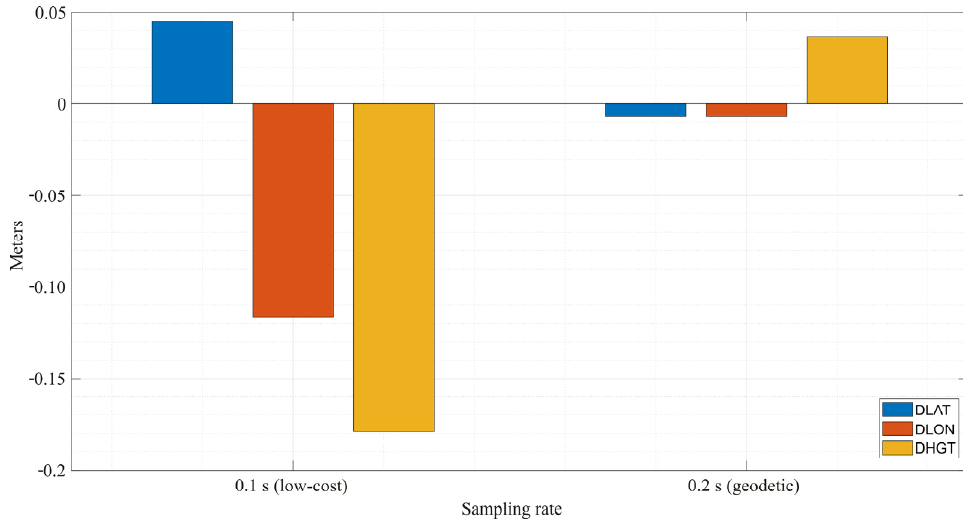
Figure 8. Difference between estimated and precise position of low-cost and geodetic receivers at 0.1 and 0.2 s respectively, by processing with PPP-static mode.